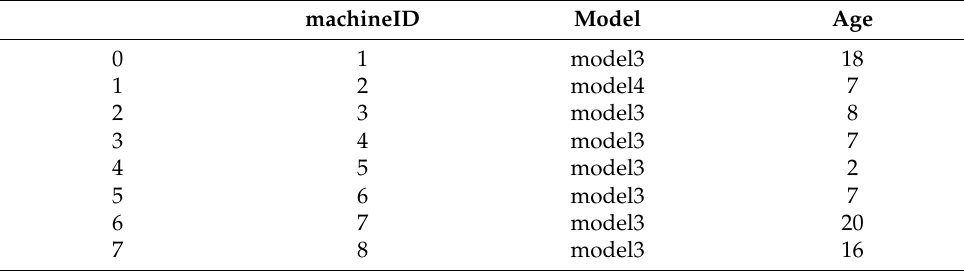
Table 6. Typical example of information for each